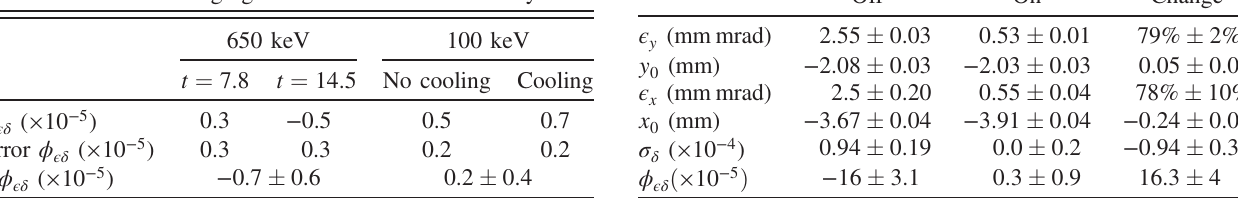
TABLE IV. Correlation coefficients calculated for the vertical scraper measurements. Results displayed in this table are in- tended for benchmarking against the horizontal case only.